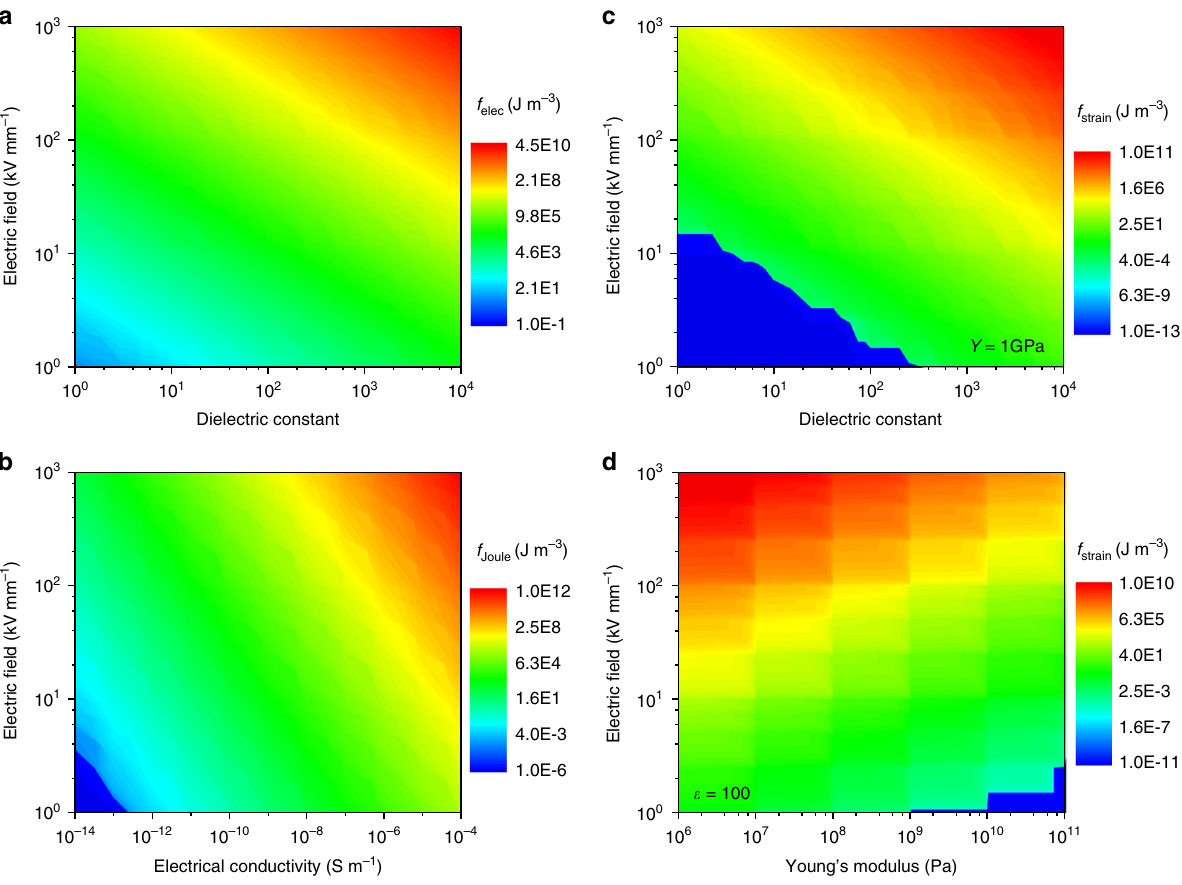
Fig. 3 High-throughput calculations of energy densities. Mapping results of a the electric energy density as a function of the dielectric constant and the applied electric fi eld, b Joule heat energy density as a function of the dielectric constant and the applied electric fi eld, c strain energy density as a function of the electrical conductivity and the applied electric fi eld, and d strain energy density as a function of the Young ’ s modulus and the applied electric fi